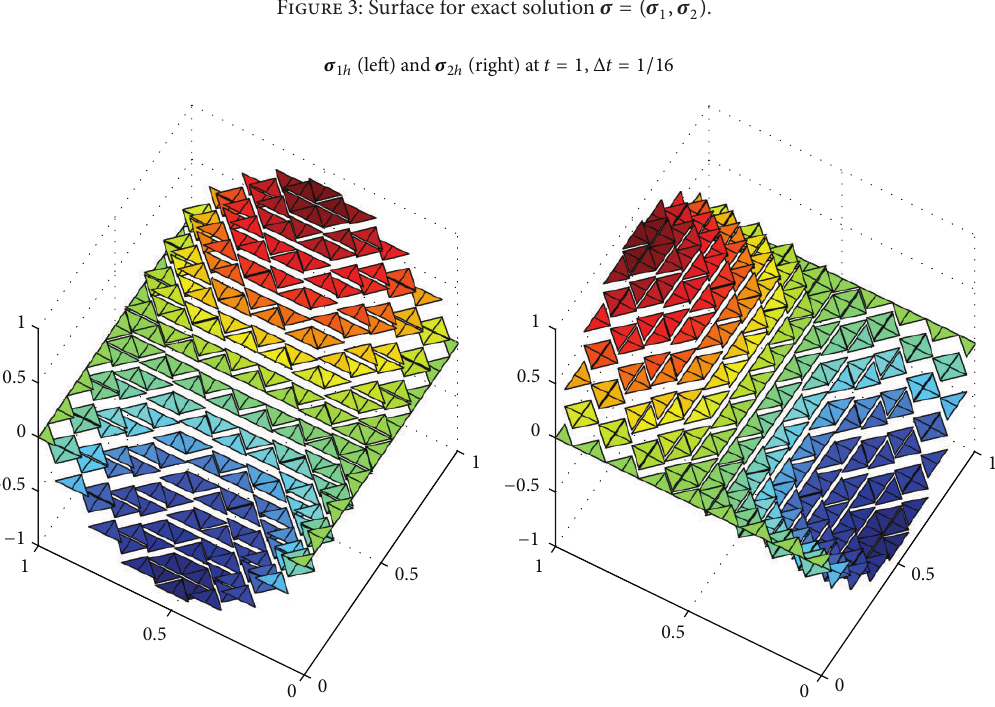
Figure 3: Surface for exact solution 𝜎 = ( 𝜎 1 , 𝜎 2 ) .